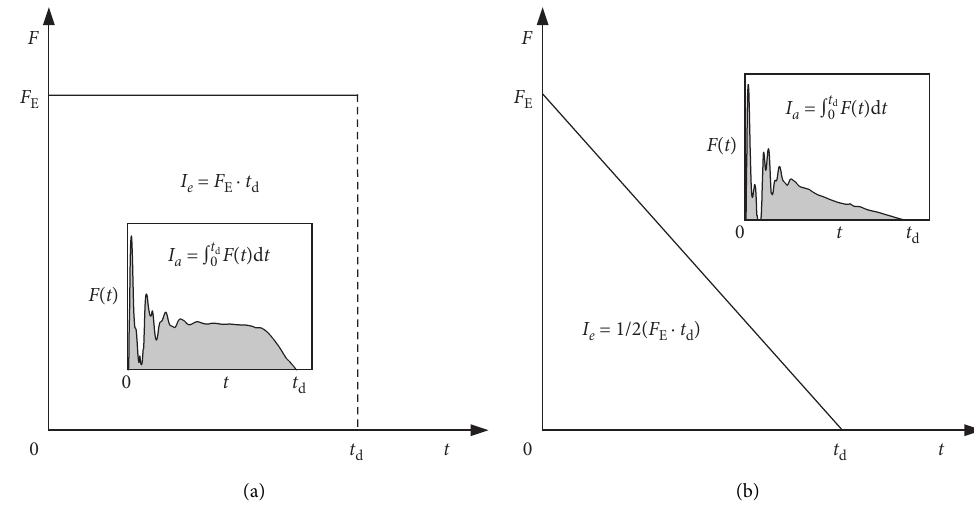
Figure 5: Equivalent pulse loads. (a) Rectangular. (b)